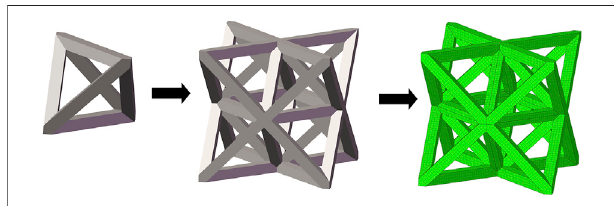
FIGURE 5 | Geometry and mesh model of one octet-truss unit